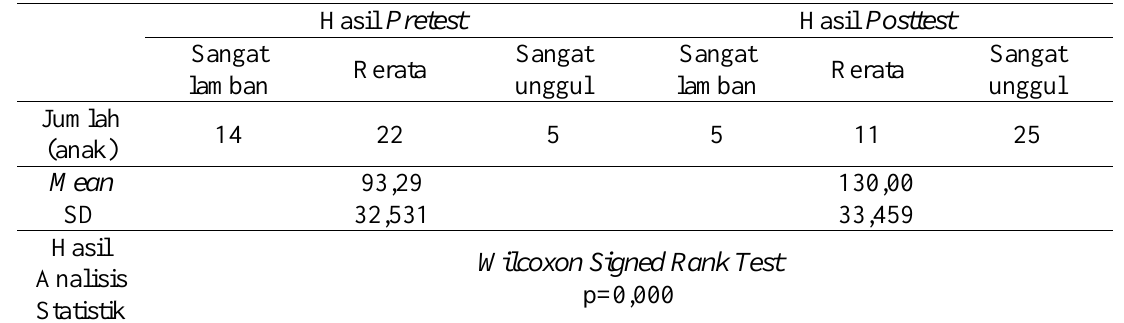
Tabel 1. Hasil analisis statistik pengaruh bermain origami terhadap perkembangan kreatifitas